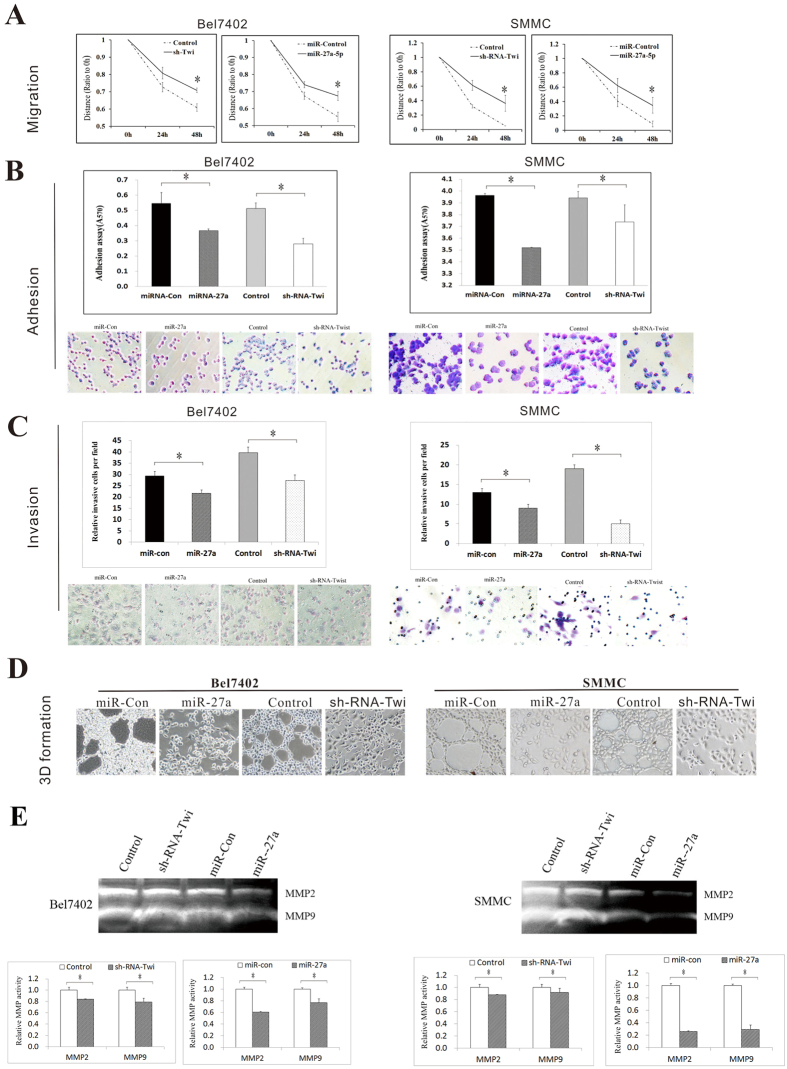
Ectopic expression of miR-27a-3p inhibited aggressive phenotypes and VM formation.Bel7402 and SMMC cells were transfected with miExpress™ Precursor miRNA Expression Clone miR-27a-3p (referred to as miR-27a) orpGP-Twist-1-shRNA (referred to as sh-RNA-Twi). The effects of miR-27a and sh-RNA-Twi on cell migration, invasion and adhesion and capillary tube formation were evaluated via (A) a wound healing assay, (B) a cell adhesion assay, (C) a transwell invasion assay, (D) a 3D VM formation assay, and (E) gelatin zymography.